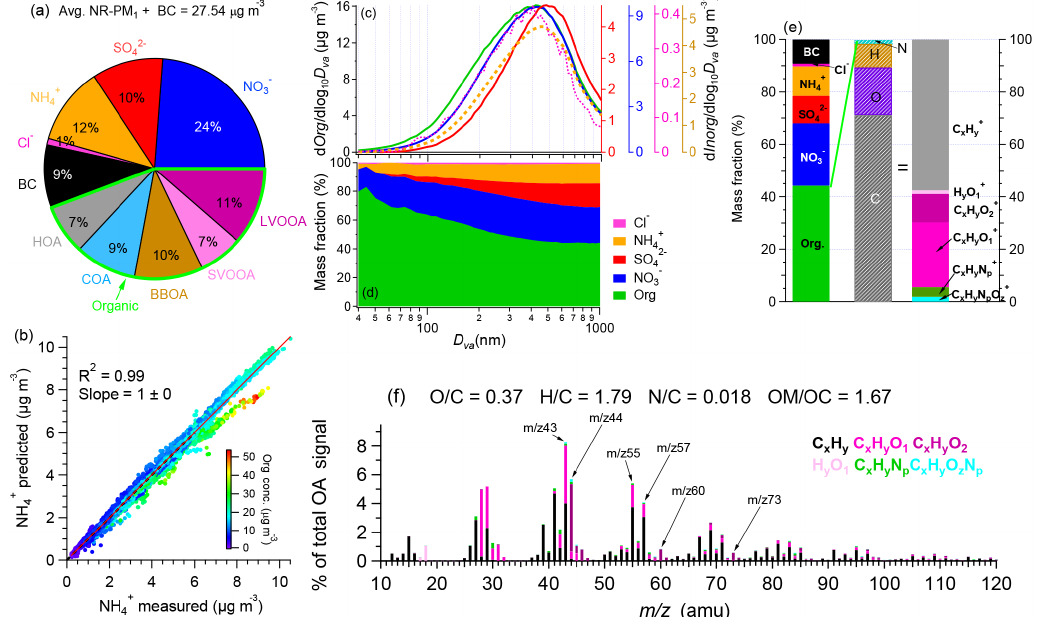
Figure 4. (a) Average compositional pie chart of PM 1 species (nonrefractory PM 1 plus black carbon (BC)) and each of the OA factors over the whole campaign. The green outline indicates the fraction of total OA and (b) shows a scatterplot that compares predicted NH + measured NH + concentrations. The predicted values were calculated assuming full neutralization of the anions (e.g., sulfate, nitrate, and 4 chloride). The data points are colored by organic concentrations. (c) Campaign-averaged size distributions for individual NR-PM 1 species; (d) averaged mass fractional contributions of each NR-PM 1 species to the total NR-PM 1 mass as a function of size. (e) Overview of the average PM 1 and OA compositions in Seoul during winter; (f) average high-resolution mass spectrum of OA colored by the different ion families. The average elemental ratios for the OA fraction are